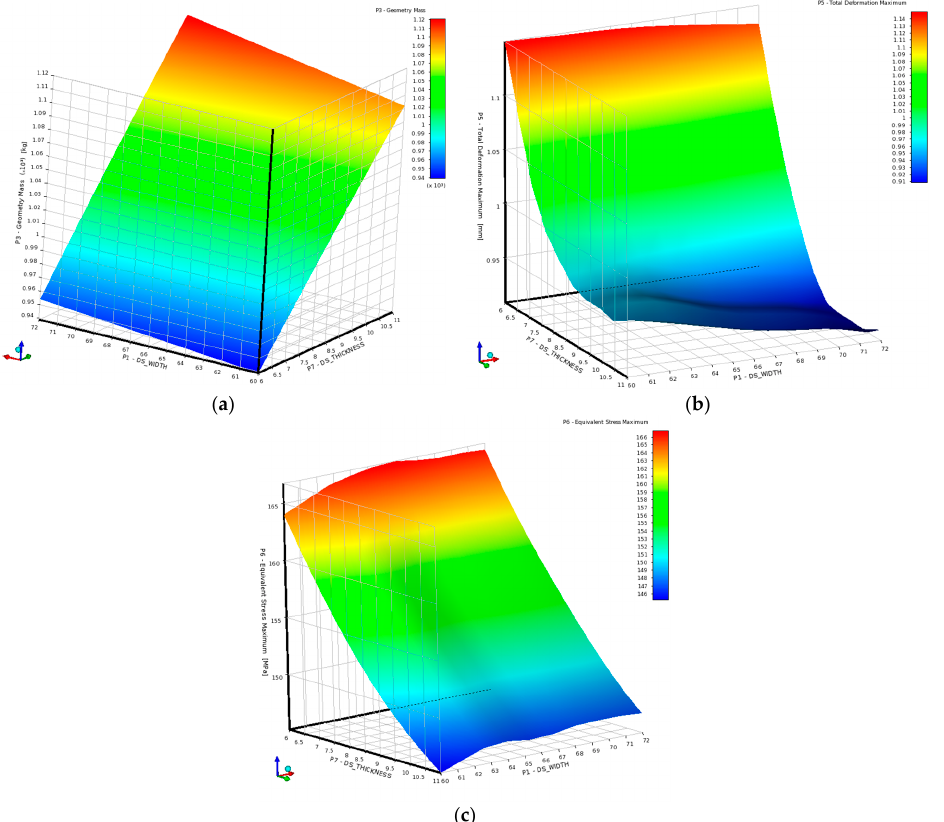
Figure 16. Response surface of structural parameters and objective function. ( a ) Effect of cross-sectional width and thickness of longitudinal beam on frame quality; ( b ) Influence of the width and thickness of the longitudinal beam section on the maximum deformation of the frame; ( c ) Effect of section width and thickness of longitudinal beam on the maximum stress in the